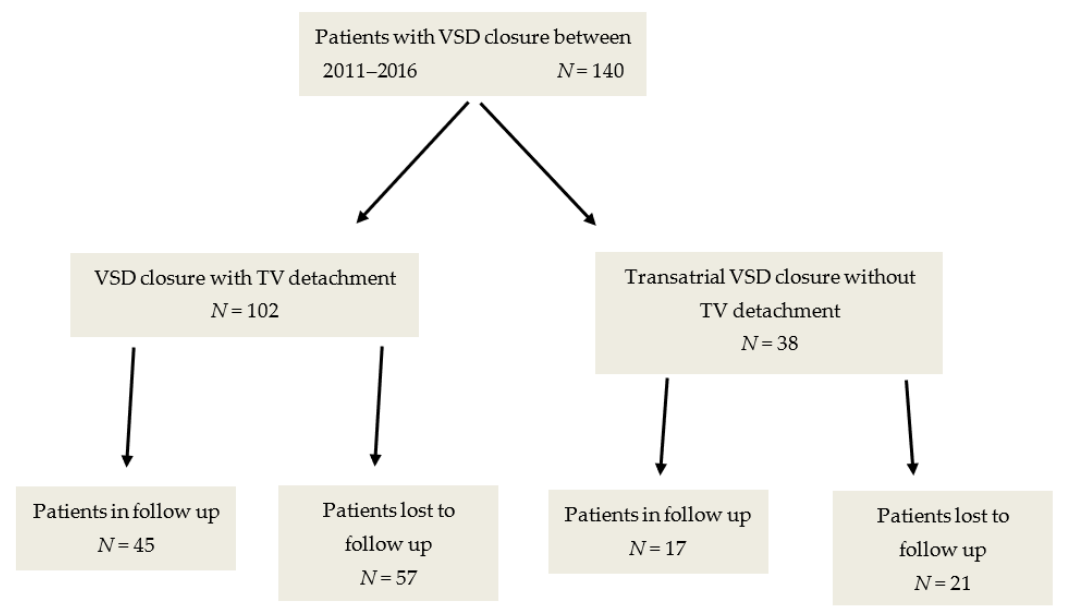
Figure 1. Patient and group selection. TV: tricuspid valve; VSD: ventricular septal defect.